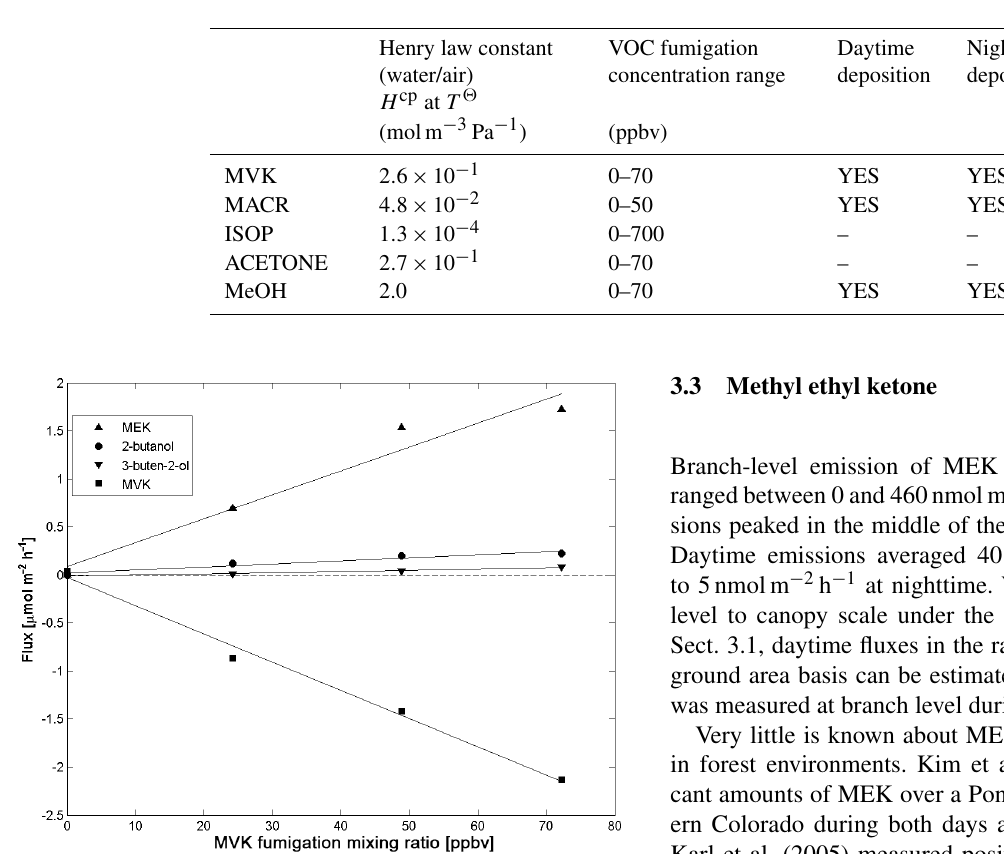
Table 3. Summary of the ancillary experiments: Fumigation of forest red oak upper-canopy branches with VOCs.